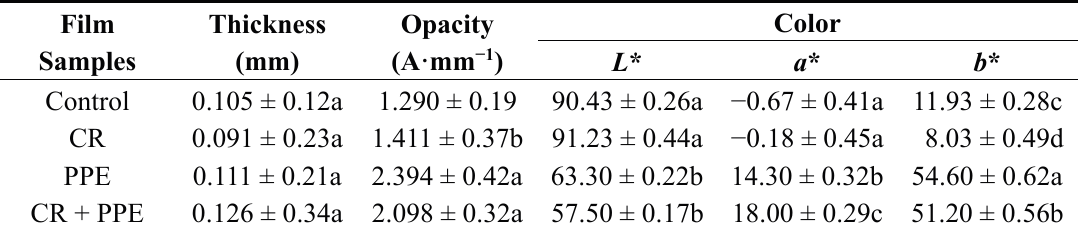
Table 1. Color value and opacity for chitosan films incorporated with pomegranate peel extract and